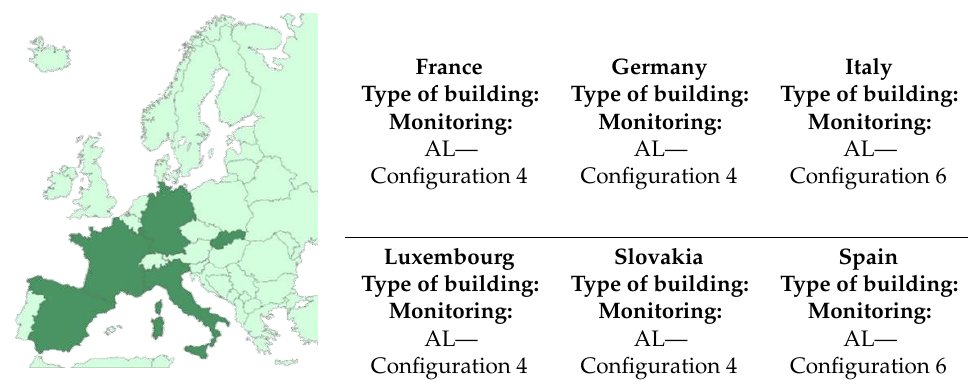
Table 3. Demonstration sites recruited within the project consortium.